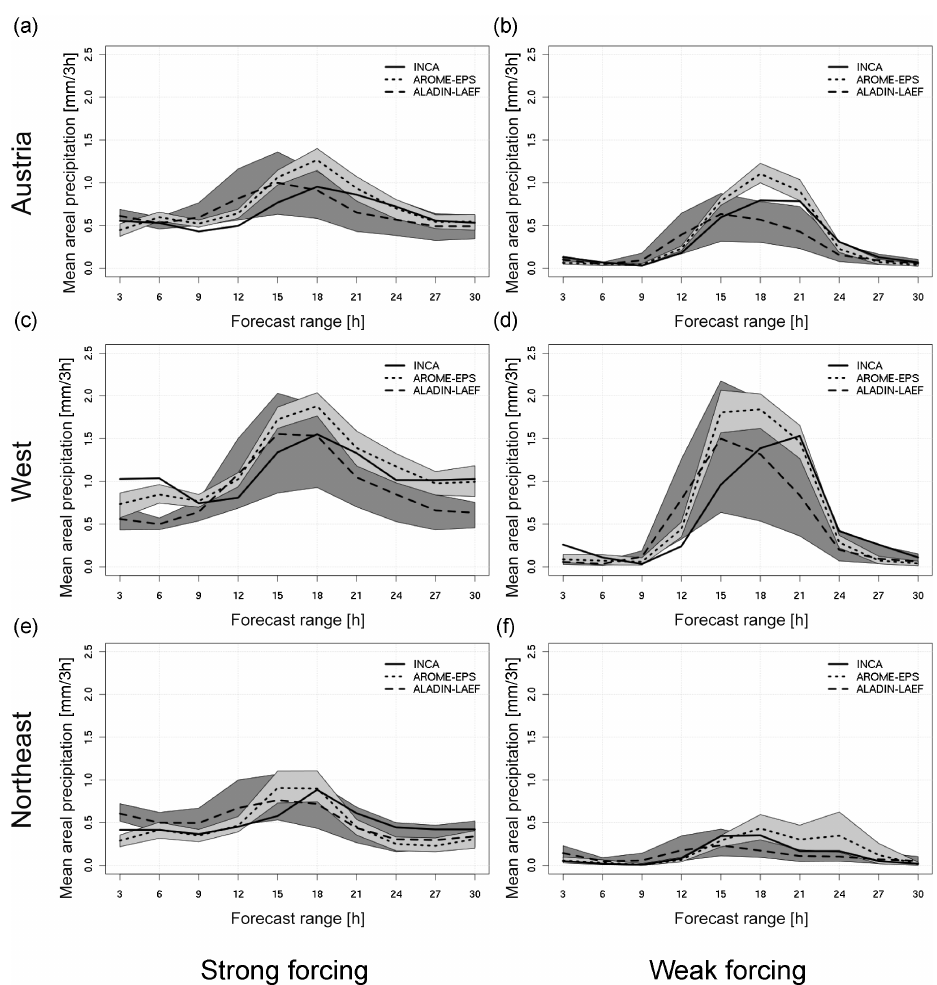
Figure 5. Time evolution of 3-hourly accumulated precipitation forecast for INCA (solid line), ALADIN-LAEF ensemble mean (dashed line), and AROME-EPS ensemble mean (dotted line) for regions Austria (top), West (middle), and Northeast (bottom). Left panels show results for the days with strong synoptic forcing, right panels for weak synoptic forcing. The shaded areas denote the range of individual ensemble member forecasts for ALADIN-LAEF (dark grey) and AROME-EPS (light grey),